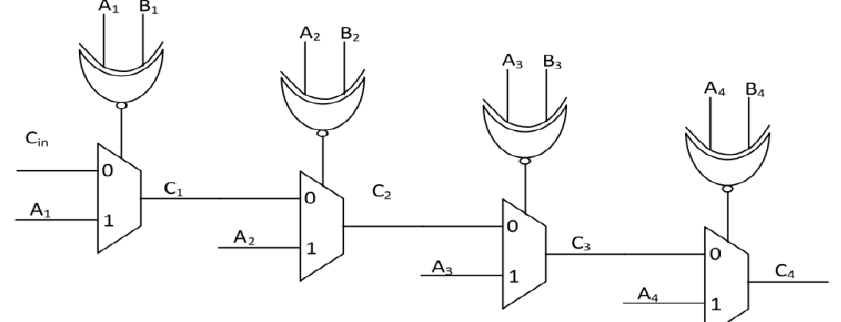
Figure 5. Generating carry out of a 4-bit RC adder based on multiplexers